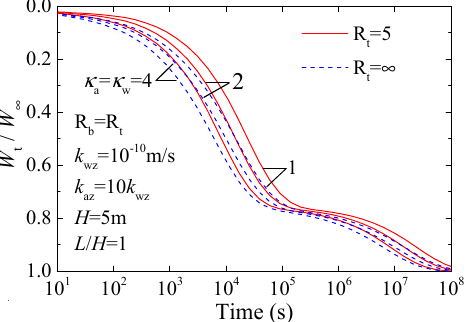
Figure 12. Variations of soil layer settlement under vertical impeded drainage boundary with different anisotropic permeability ratios.